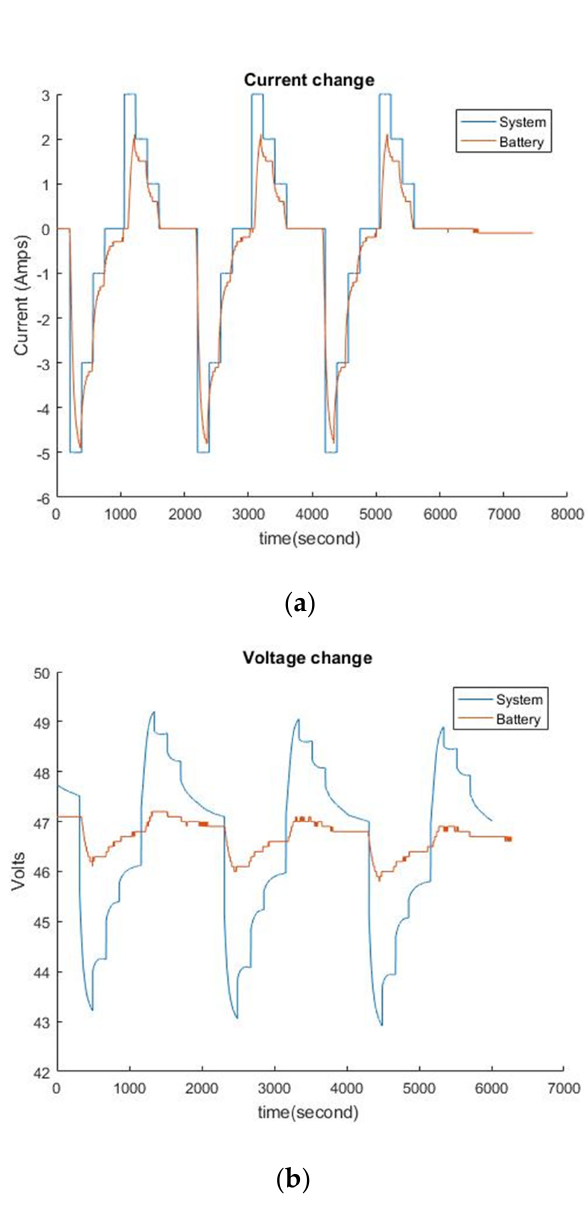
Figure 6. ( a ) Discharge current of battery and system (battery/ultracapacitor (UC)); ( b ) voltage drop of battery and system.